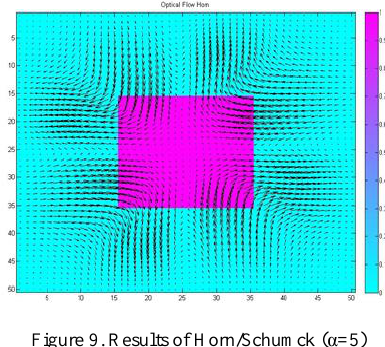
Figure 5. Results of Horn/Schumck (α=0.5)